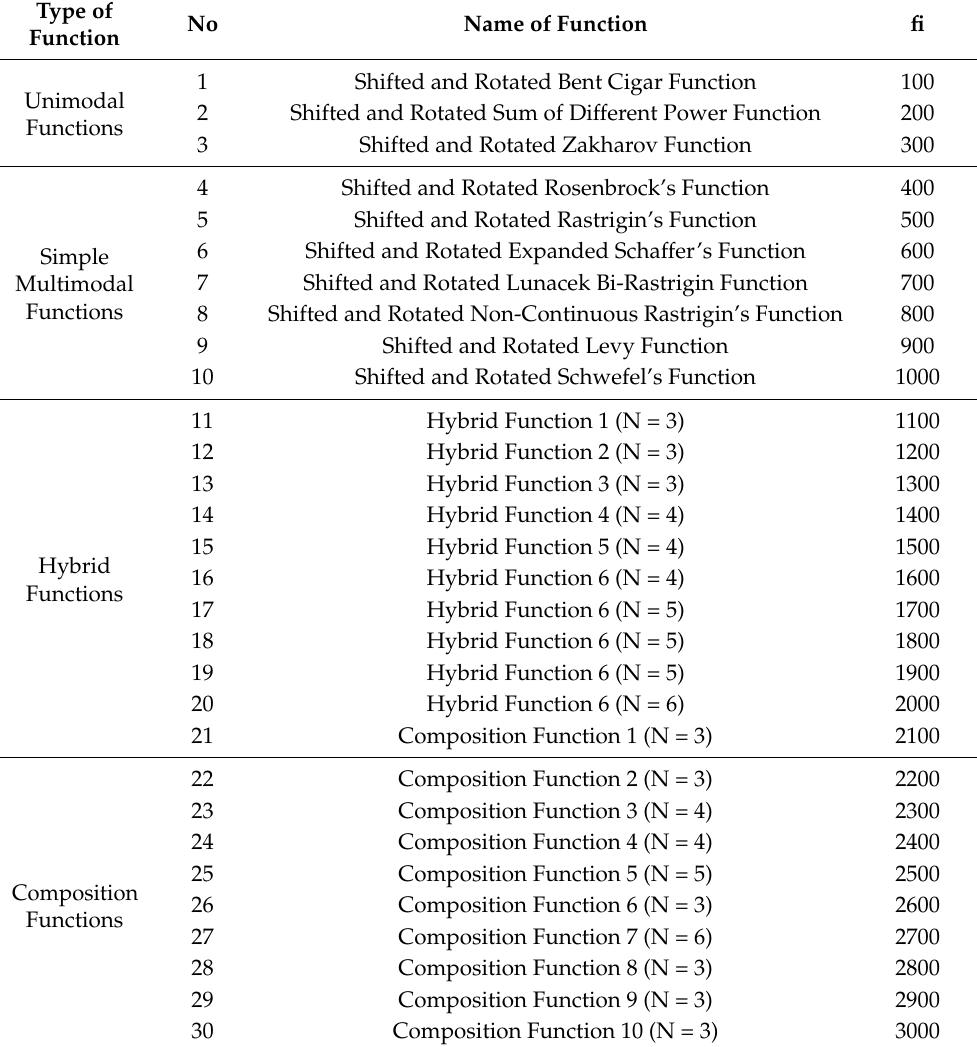
Table 1. CEC 2017 optimization